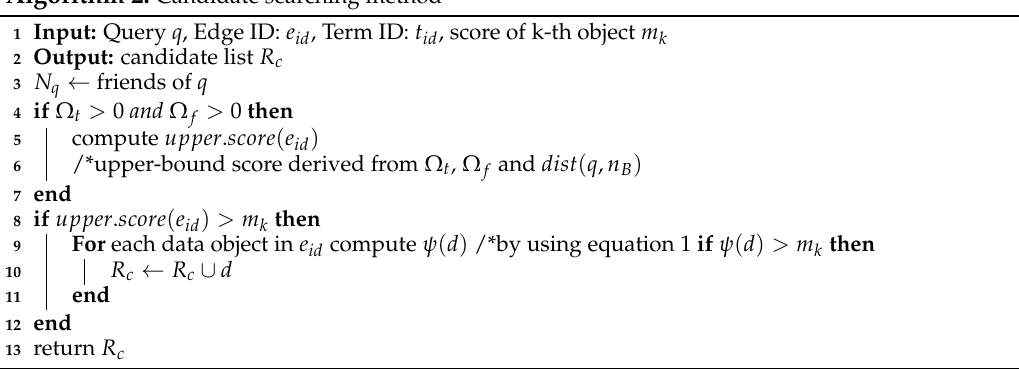
Algorithm 2: Candidate searching